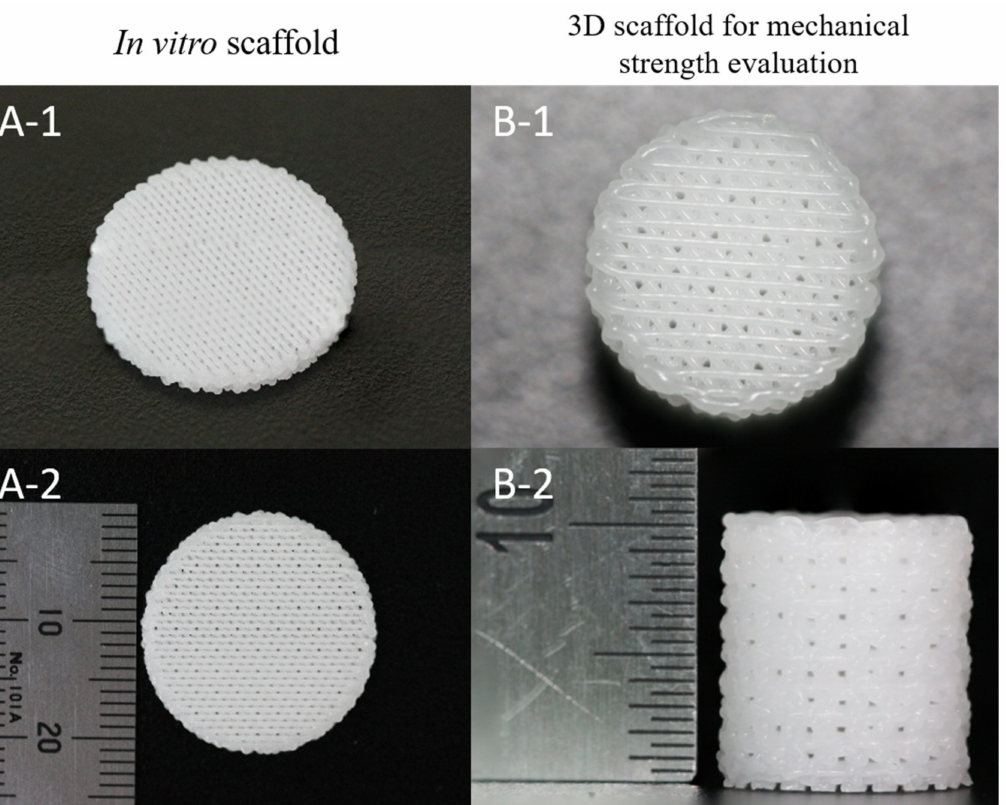
Figure 1. Scaffold photographs used in this study: ( A-1 ) plane view image, ( A-2 ) side view image of 3D scaffold for in vitro test; ( B-1 ) plane view image, ( B-2 ) side view image of 3D scaffold for mechanical strength evaluation (( A-1 ): diameter = 20 mm, ( A-2 ): height = 1.2 mm, ( B-1 ): diameter = 10 mm, ( B-2 ): height = 10 mm).